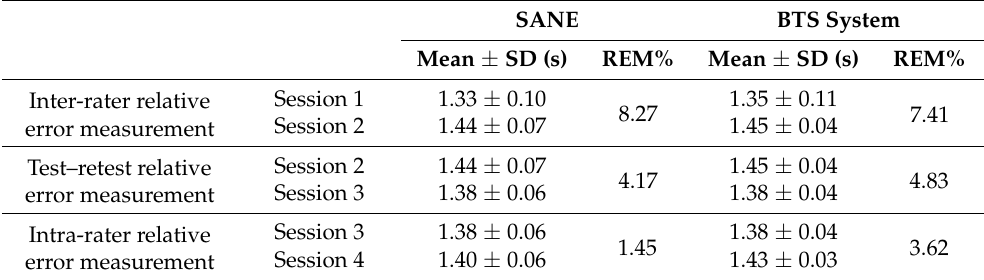
Table 4. Results for gait cycle duration.